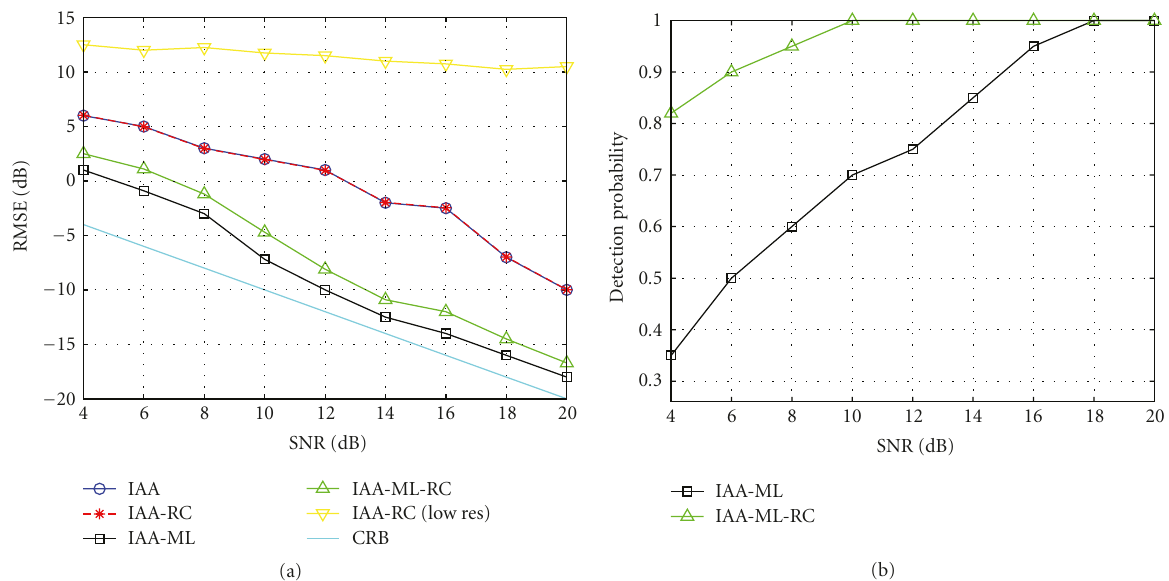
Figure 11: (a) RMSE of the di ff erent beamforming solutions. (b) IAA-ML versus IAA-ML-RC detection probability (rectangular array, θ 1 = 10 ◦ , φ 1 = 150 ◦ , θ 2 = 40 ◦ , φ 2 = 188 ◦ , θ 3 = 20 ◦ , φ 3 = 250 ◦ , N = 10 snapshots, noise power equal to 0dB, and f c =